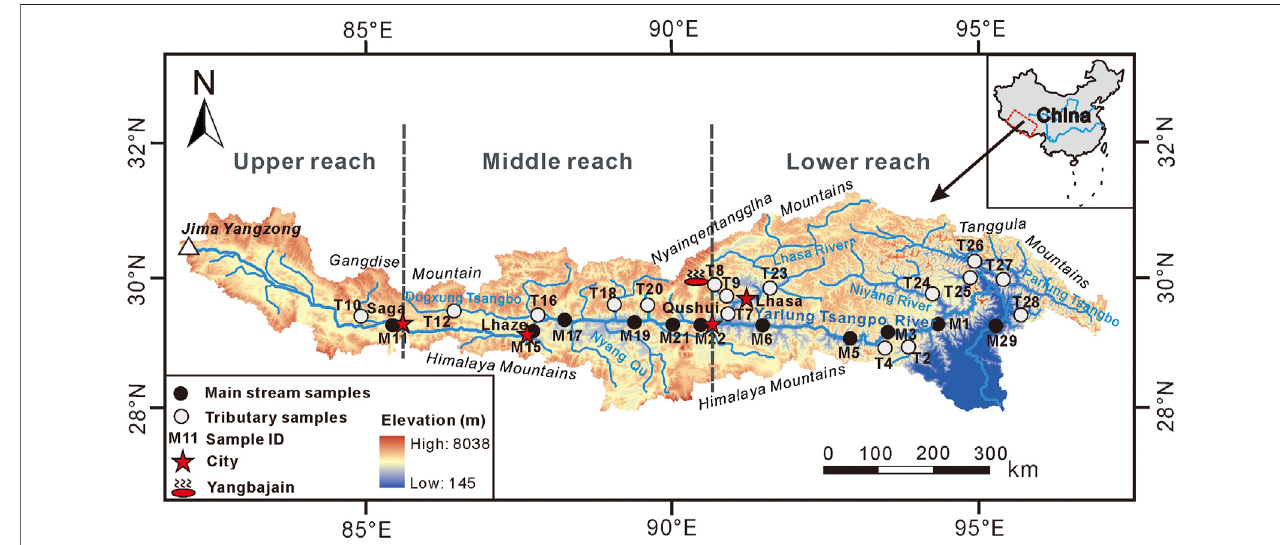
FIGURE 1 | Sampling sites in the YTR Basin (Modi fi ed from Zhang et al., 2021).